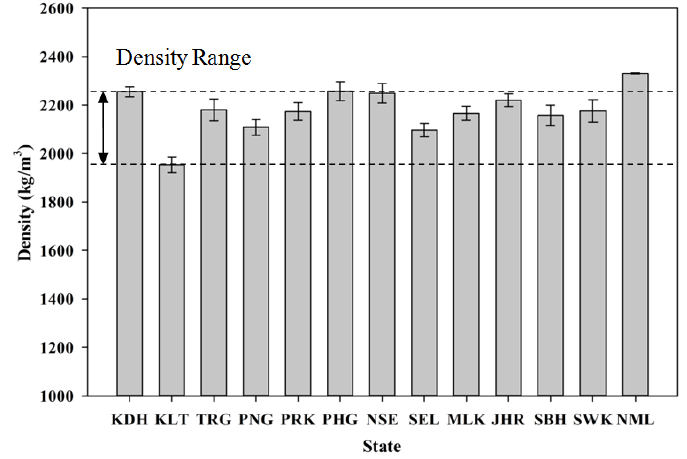
Figure 12. Variation in density for the samples of each state.